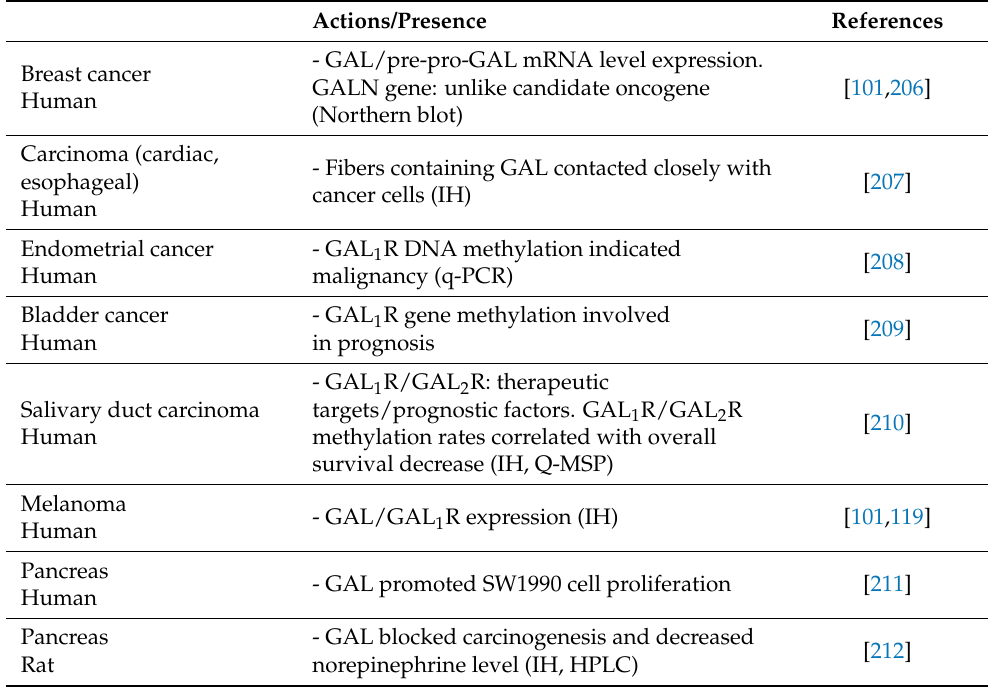
Table 5. Involvement of the galaninergic system in other